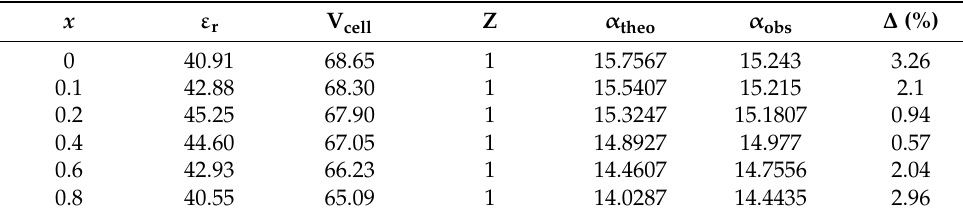
Table 4. Comparisons between α theo and α obs of Ba 1– x Sr x (Zn 1/3 Nb 2/3 )O 3 ceramics. x ε r V cell Z α